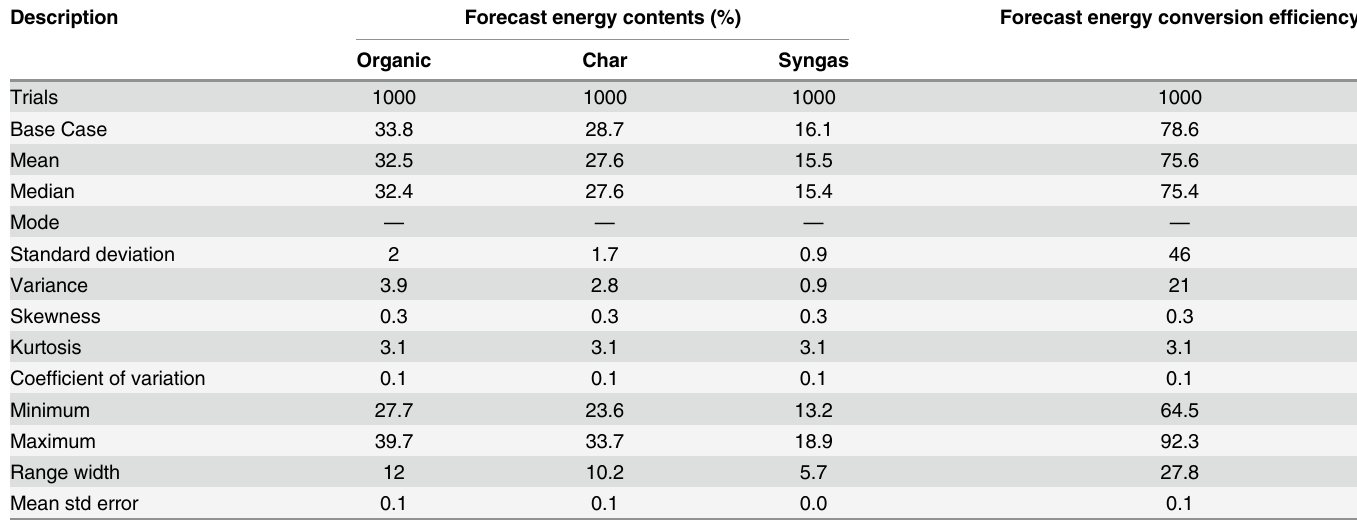
Table 3. Forecasting values of energy recovery and energy conversion efficiency at optimum